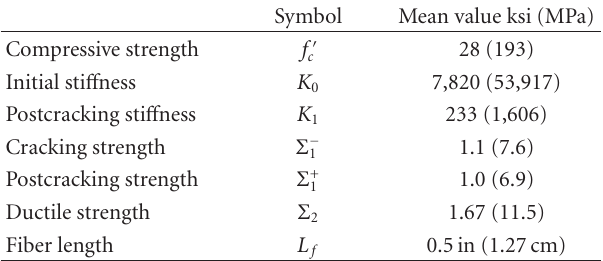
Table 3: Material identity card for Ductal (sf). Mean values ob- tained from direct notched tensile plate